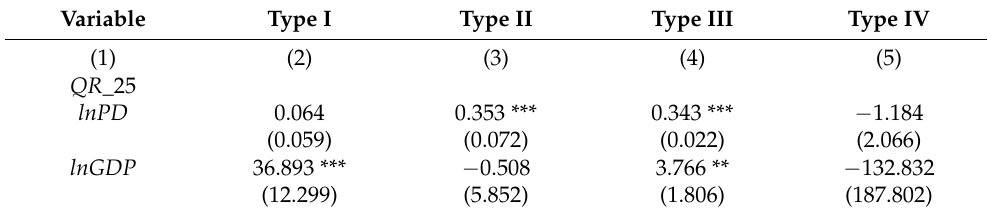
Table 5. Quantile regression results of factors influencing urban PM 2.5